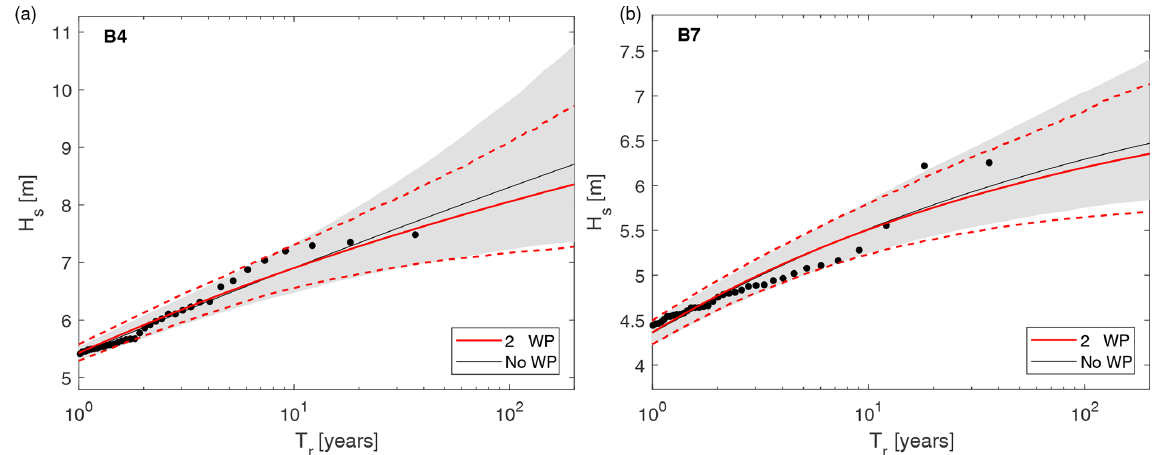
Figure 13. Omni-WP extreme value distributions of H s obtained from the whole set of peaks (black) and from combining single-WP distributions (red), along with 90% confidence intervals (gray shading and red dashed lines, respectively). (a) B4; (b)